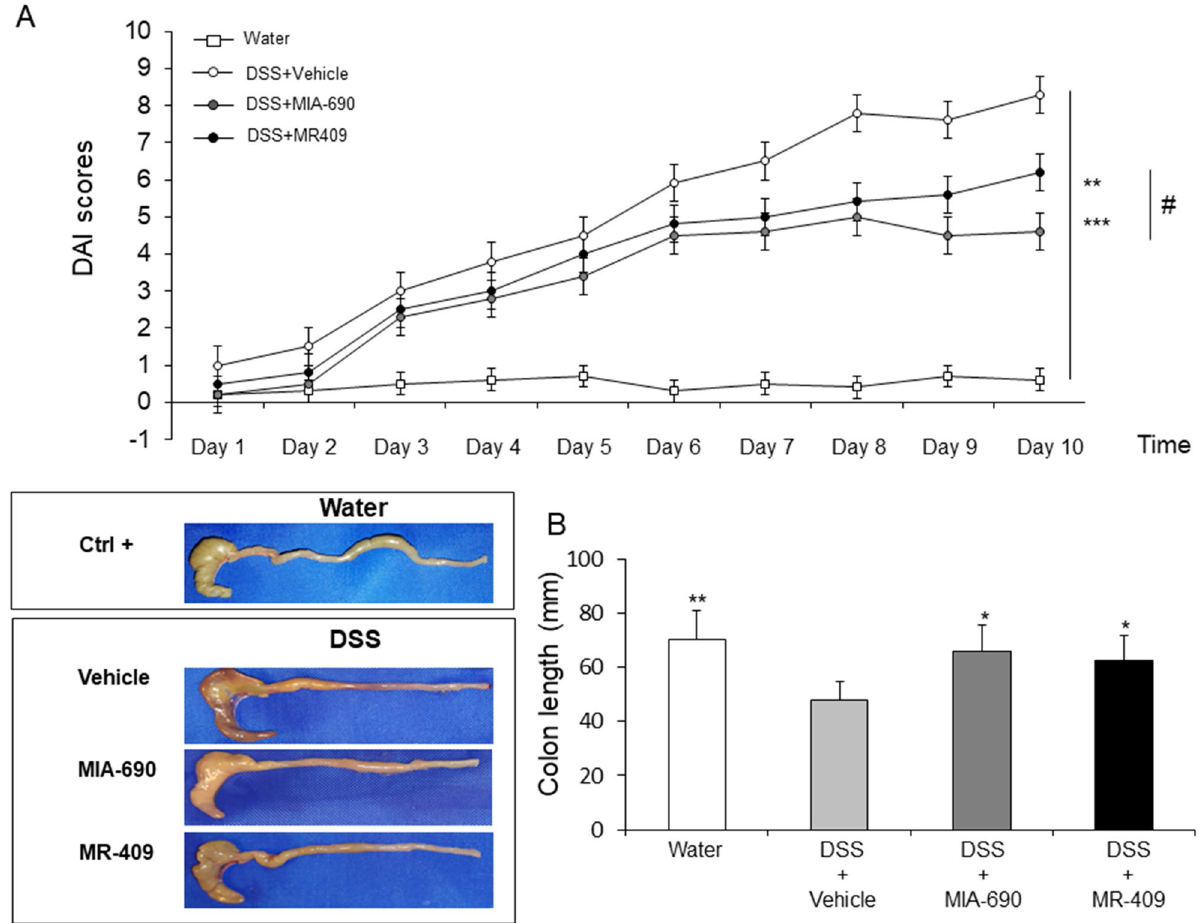
Figure 6. Effect of MIA-690 (5 µg) and MR-409 (5 µg) (n = 6 for each group of treatment) s.c. administration on relative DAI scores ( A ) and colon segment lengths ( B ) in a model of DSS-induced colitis. Data are expressed as means ± S.E.M. and analyzed by analysis of variance (ANOVA) followed by Bonferroni post-hoc test * p < 0.05, ** p < 0.01, *** p < 0.005 versus DSS-treated MIA‑690 and MR‑409 reduce responsiveness to acute inflammation stimuli. With the aim to determine the responsiveness to acute inflammation stimulation mice were tested by formalin test. MIA-690 (5 μg) or MR-409 (5 μg) were s.c. injected daily for 4 weeks in mice. Control animals received s.c. injection of vehicle (0.1% DMSO (Sigma) and 10% propylene glycol). The evaluations were performed after 2 and 4 weeks of treatment. After intraplantar injection of formalin, mice treated with MIA-690 (5 μg) or MR-409 (5 μg) showed short nociceptive behavioural responses (first and second phase) compared to vehicle groups [Fig. 4; p < 0.05 and p < 0.01], at both 2 and 4 weeks. In second phase, we showed that s.c. injection of MR-409 significantly decreased nociceptive behavioural response at both 2 and 4 weeks of treatment compared to MIA-690 [Fig. 5; p < 0.05]. MIA‑690 and MR‑409 reduce disease activity index (DAI) score and colon length in DSS‑induced colitis. DSS (2.5%)-induced colitis was induced to investigate the potential effects of MIA-690 (5 μg) and MR-409 (5 μg) on inflammatory stimuli. DSS treatment led to higher DAI score in all treated groups as com- pared to controls (mice untreated with DSS). MIA-690 (5 μg) or MR-409 (5 μg) treated mice displayed signifi- cantly lower susceptibility to DSS treatment starting from day 2 [Fig. 6, panel A; p < 0.01 and p < 0.005]. However, treatment with MIA-690 (5 μg) or MR-409 (5 μg) did not induce a significant reduction in mortality respect to vehicle treated animals (n = 1/10 for all groups; data not shown). minor decrease in colon segment length respect to DSS treated animals, suggesting that both peptides induce a lower sensitivity to chronic inflammation stimuli [Fig. 6, panel B; p < 0.05]. No significant difference was found between MIA-690 and MR-409 treated mice in DAI score and colon segment length.